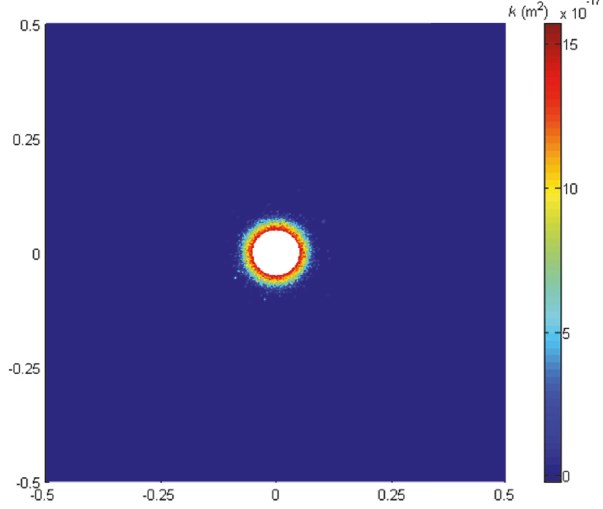
Figure 8: Permeability distribution of borehole surrounding rock.